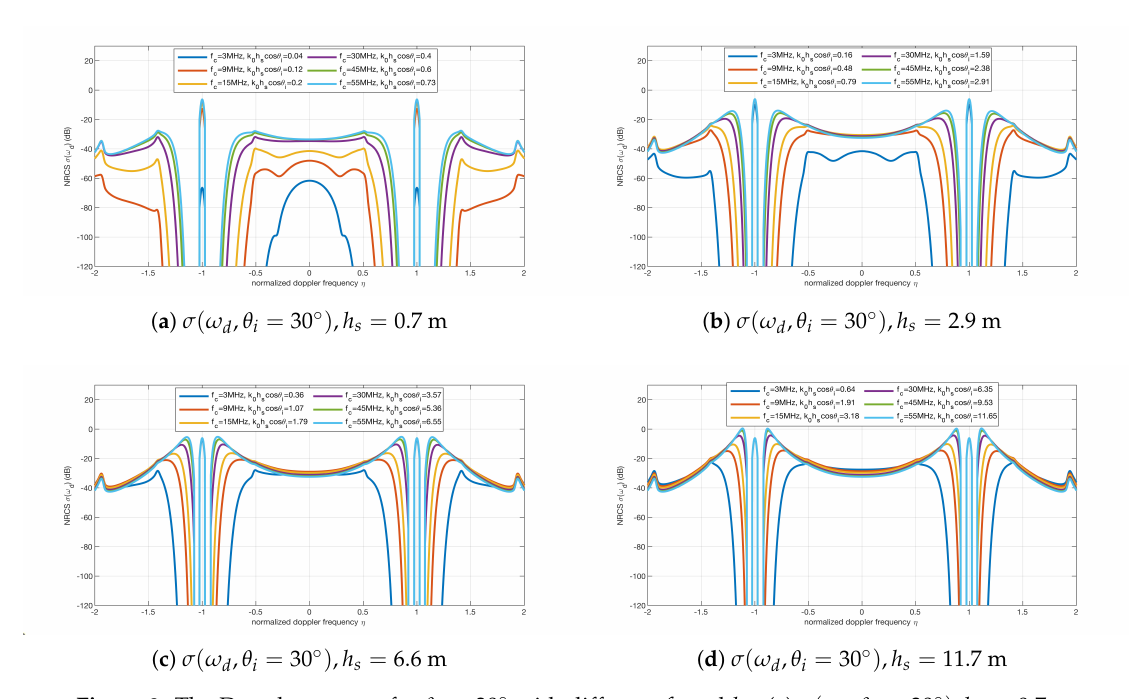
Figure 3. The Doppler spectra for θ i = 30 ◦ with different f c and h s . ( a ) σ ( ω d , θ i = 30 ◦ ) , h s = 0.7 m; ( b ) σ ( ω d , θ i = 30 ◦ ) , h s = 2.9 m; ( c ) σ ( ω d , θ i = 30 ◦ ) , h s = 6.6 m; and ( d ) σ ( ω d , θ i = 30 ◦ ) , h s = 11.7 m. For each pair of θ i and h s , six radar frequencies were selected to simulate the spectra. The six values of f c were 3, 9, 15, 30, 45 and 55 MHz. The dominant wave direction α (cid:48) is 90 ◦ .